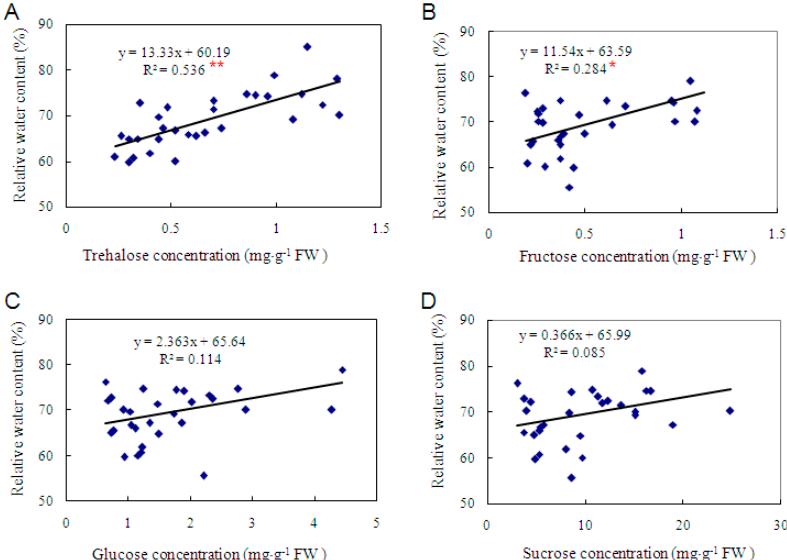
Figure 3. Correlations between soluble sugar contents including: trehalose ( A ); fructose ( B ); glucose ( C ); and sucrose ( D ) in different cassava varieties and water retaining capacities of their detached leaves. The significance of the correlations was analyzed using IBM SPSS Statistics Version 24.0, and the correlation curves were created with Excel 2007 (Microsoft Inc., Seattle, WA, USA). ** and * indicate significant correlations at 1% and 5% levels of significance, respectively.